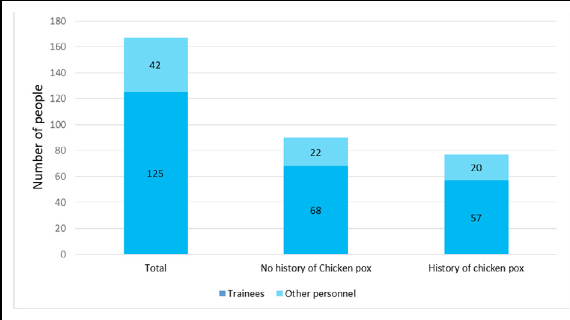
Figure 1. Bar graph showing total person in training centre with past infection status (n=